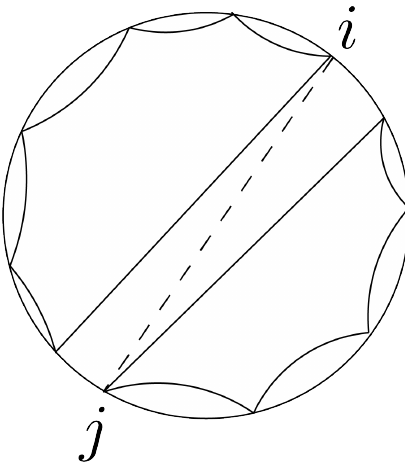
Figure 21 . The transposition ( i, j ) breaks the cyclic permutation τ into two cycles divided across the chord joining points i and j . In order to satisfy the geodesic condition, all further transpositions should act on elements within the given cycles. Thus, we end up with a non-crossing